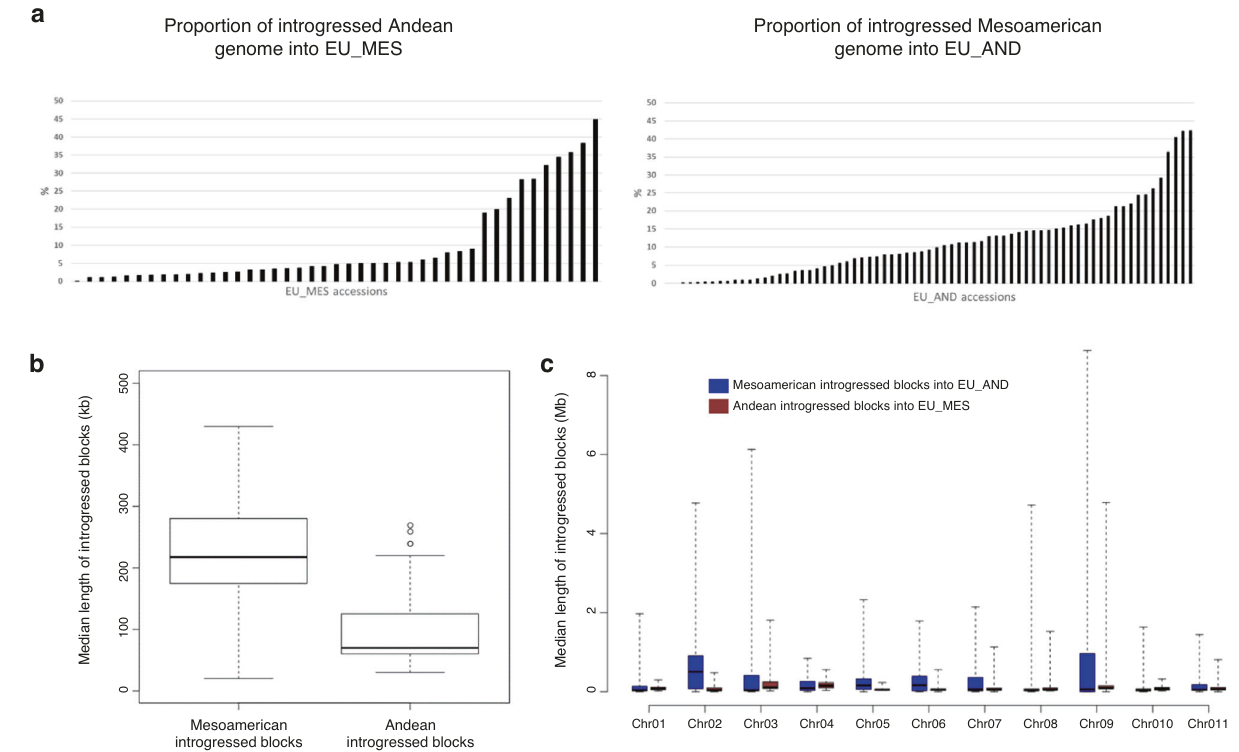
Fig. 3 | Mapping introgression in the European common bean using Chromo- Painter. a Proportion of introgressed genome in the Mesoamerican (EU_MES; n =43) and Andean (EU_AND; n =71) groups. b , c Boxplots showing the median length of the introgressed blocks identi fi ed in each of the EU_AND and EU_MES accessions across all of the chromosomes and the median length of the